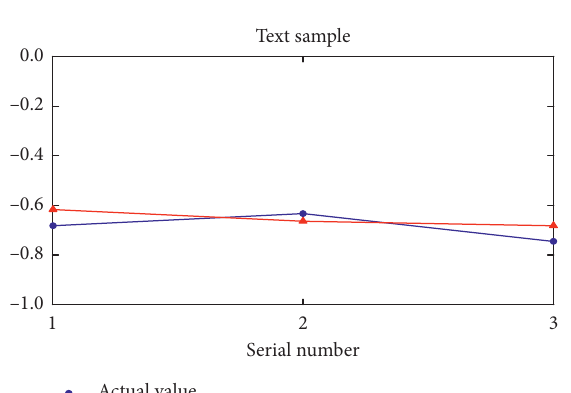
Figure 24: Residual training samples.